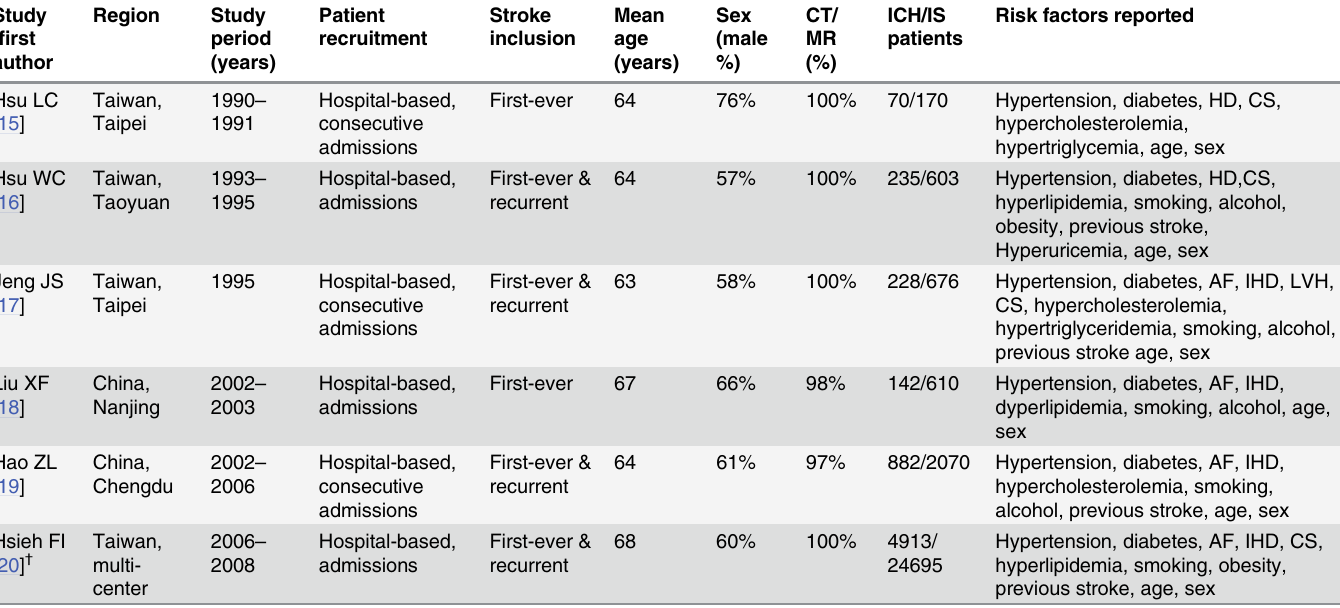
Table 1. Clinical characteristics of included studies in Chinese populations.